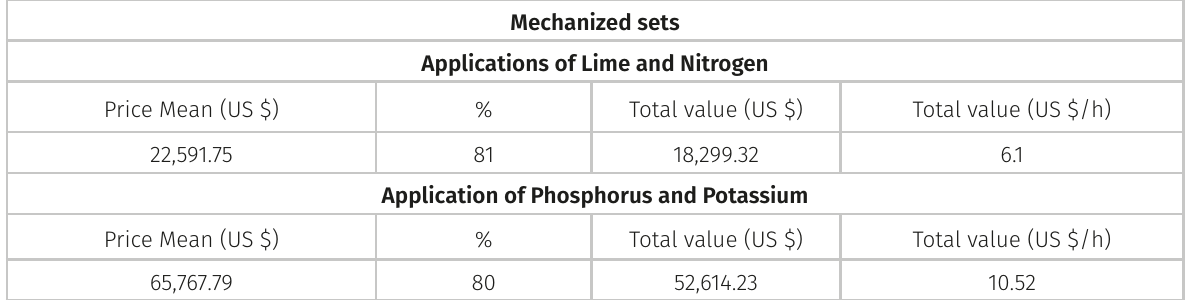
Mechanized sets Applications of Lime and